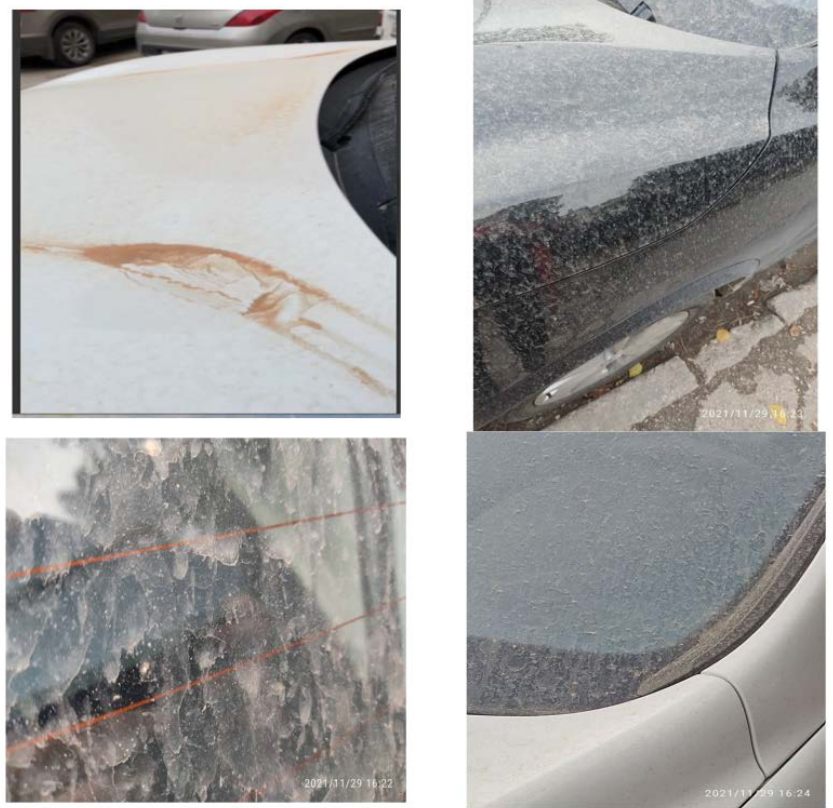
Figure 10. Terrigenous particles deposited on cars in Sevastopol as a result of the dust storm from the Sahara on 29 November